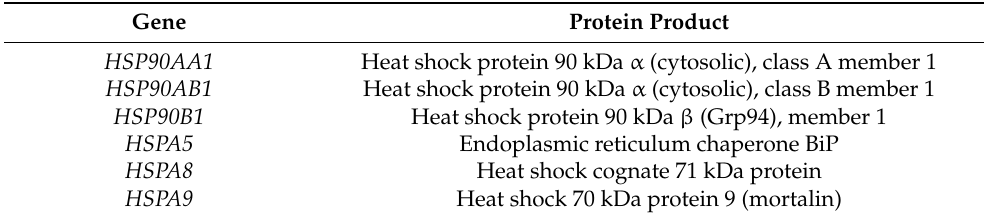
Table 4. Differentially expressed hsp-coding genes in RKO colon carcinoma cells submitted to subchronic low-dose CdCl 2 exposure